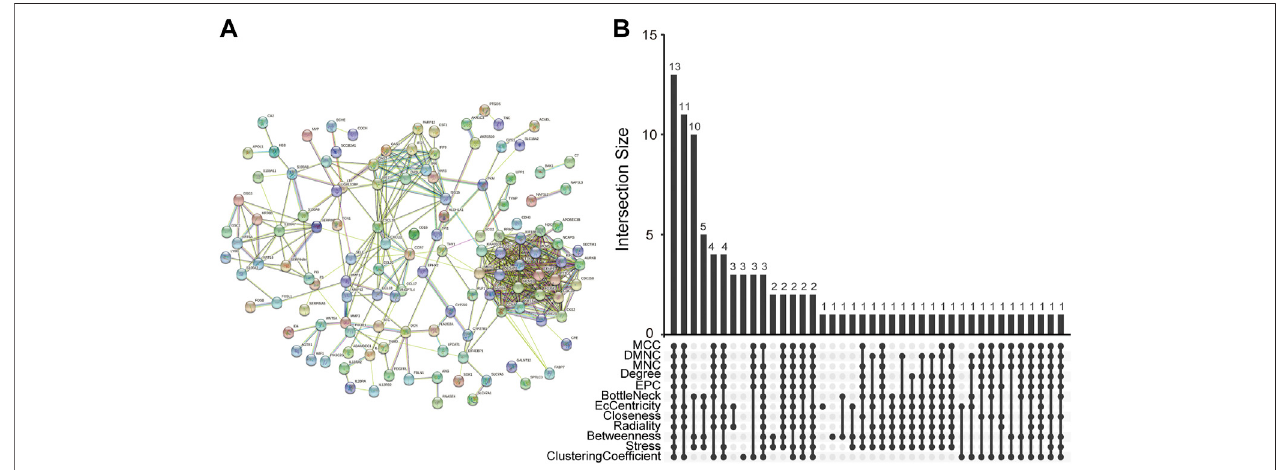
FIGURE 5 | Determination of candidate hub genes. (A) The PPI network of co-DEGs. (B) Candidate hub genes were screened out using 12 algorithms. PPI, protein-protein interaction; co-DEGs, common differentially expressed genes.